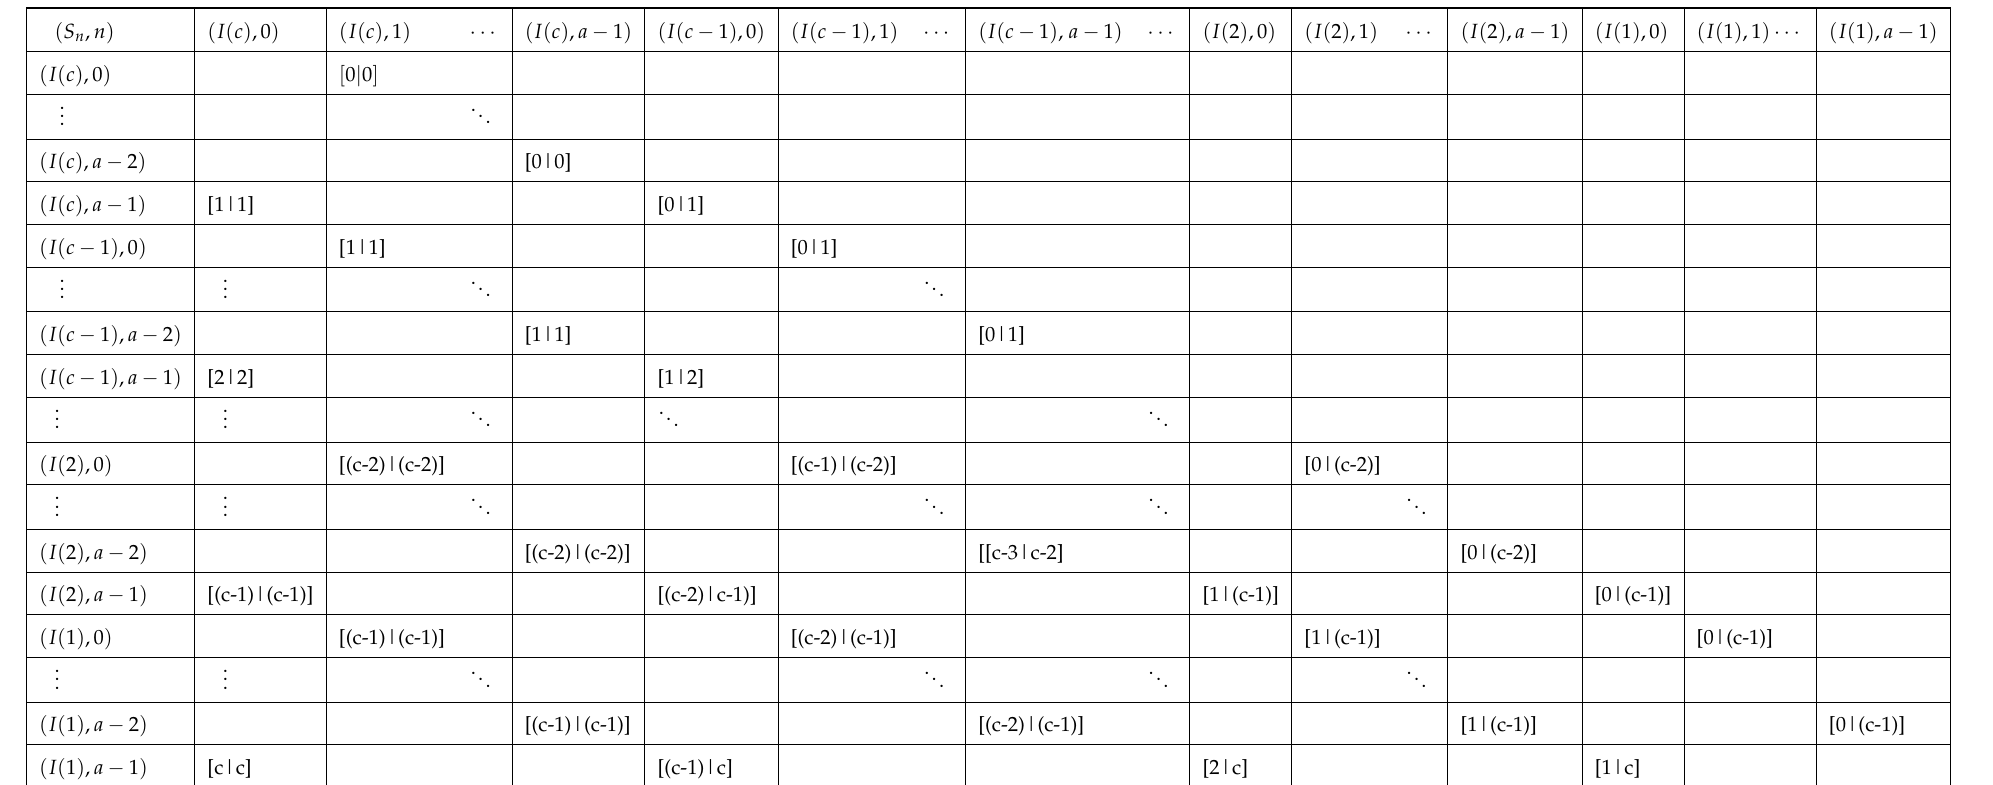
Table 1. Submatrix T Idle → Idle